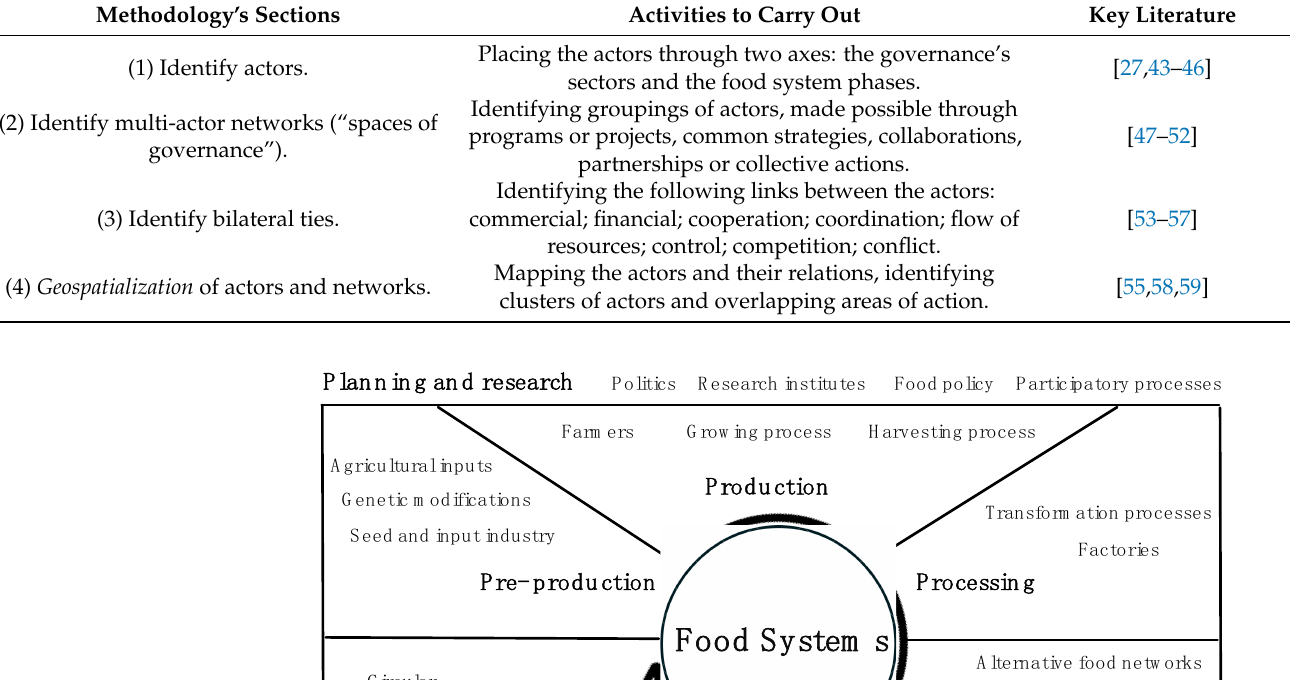
Activities to Carry Out Key Literature (1) Identify actors.